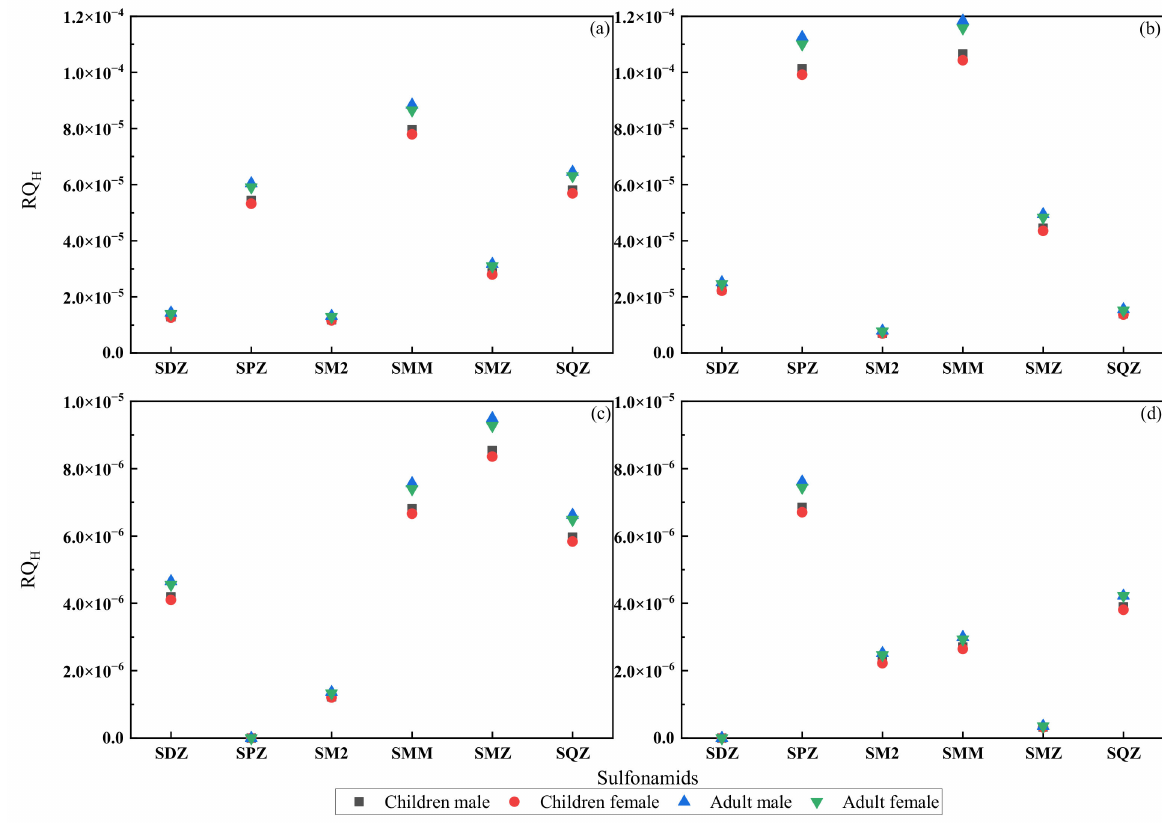
Figure 9. Comparison of the RQH in Shaanxi section of the Weihe River from 2016 to 2021: ( a ) the flat water period in 2016; ( b ) the wet water period in 2016; ( c ) the wet water period in 2020; ( d ) the flat water period in